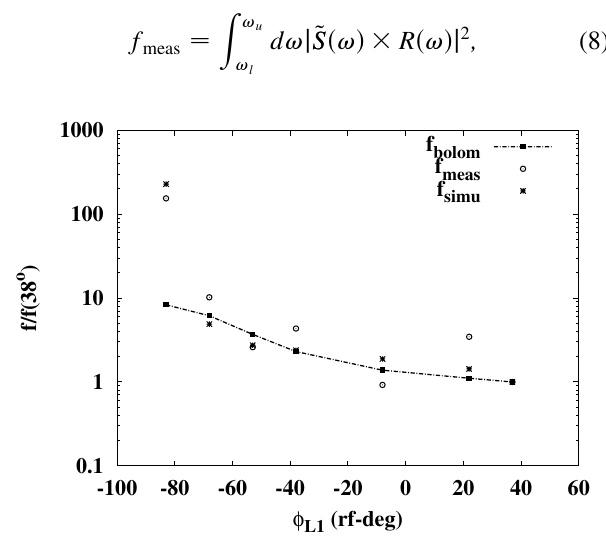
FIG. 8. Integrated bunch form factor f normalized to its (cid:3) 38 (cid:12) . f , f , and f correspond, respec- value at % L1 bolom meas simu tively, to measurement with the bolometer, computation from the measured time profiles, and computation from the simula- tion-generated time profiles.